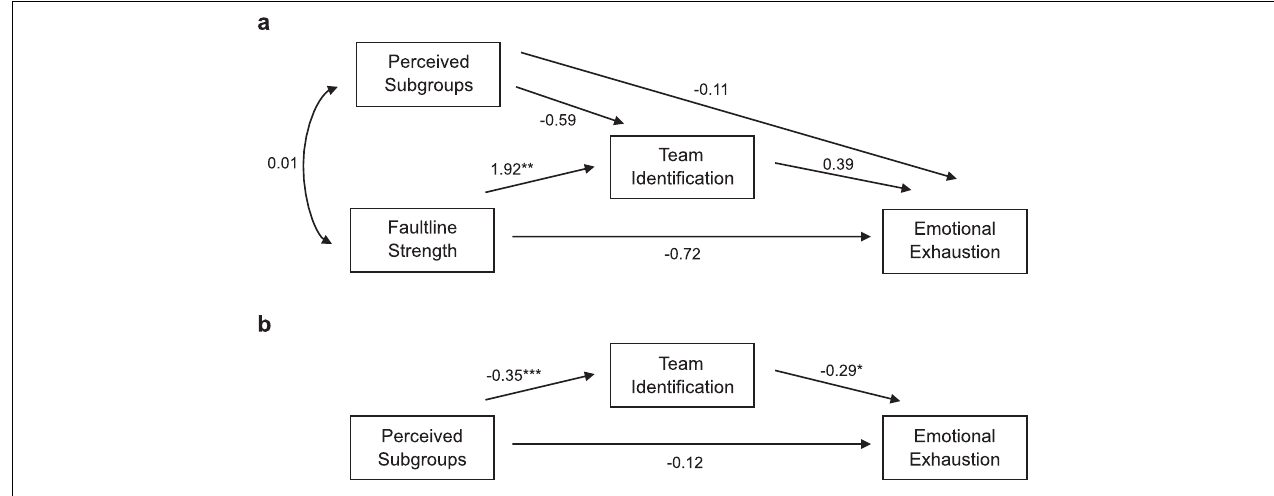
FIGURE 2 | (a) Between and (b) within effects of the tested multilevel path model for Hypotheses 1a and 1b. Note that for the sake of clarity, the control variables are omitted from this diagram although they were included in the analysis. * p < 0.05, ** p < 0.01, *** p < 0.001.